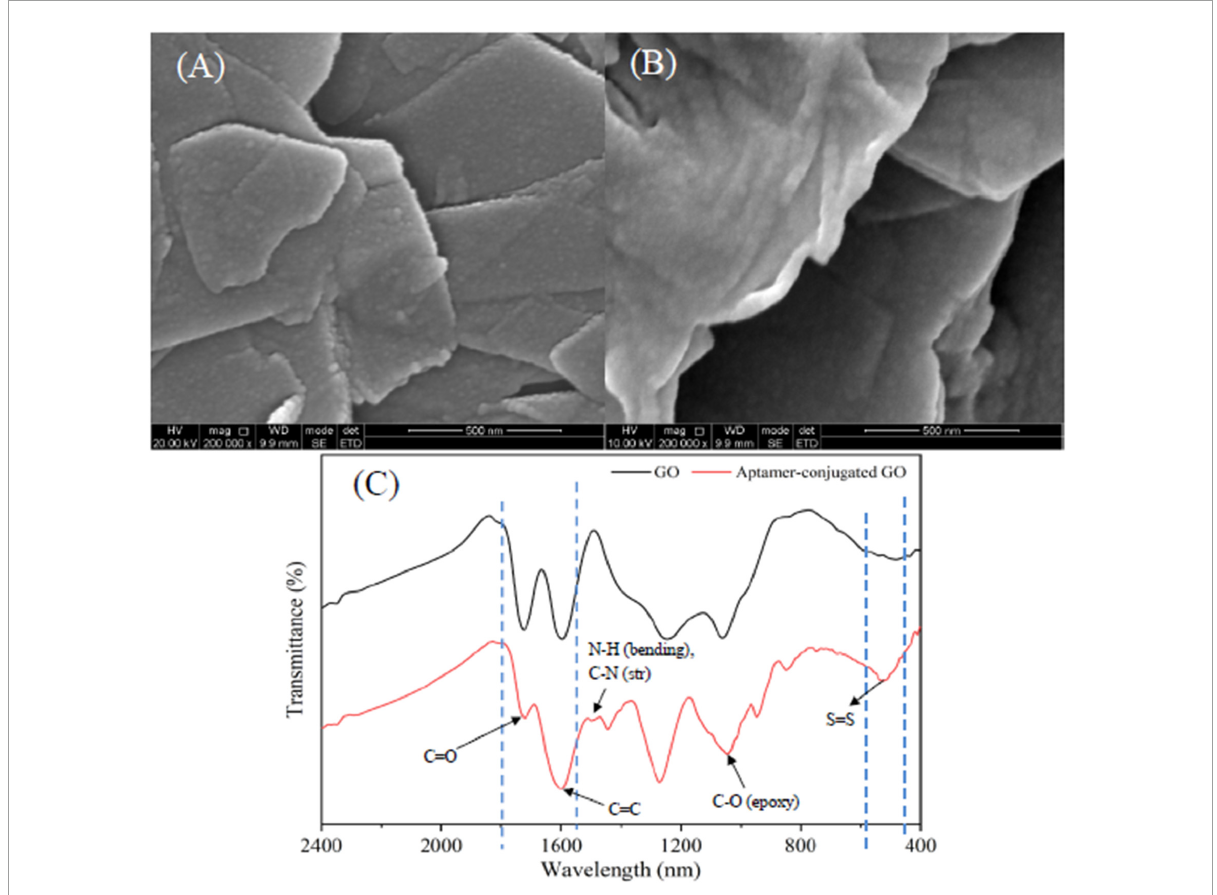
FIGURE2 SEM micrographs of graphite (A) and GO (B) ; FT-IR spectra of GO and aptamer-modified GO nanoparticles (C)